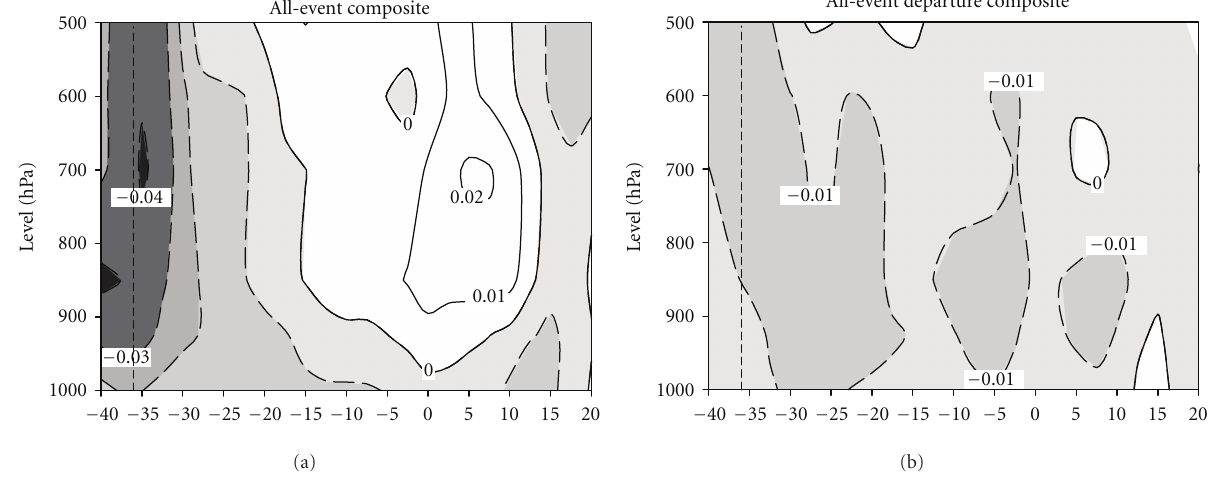
Figure 10: Same as Figure 8 but for the vertical velocity (10 − 3 hPa · s − 1 ). Upward motion (negative values) is shaded.